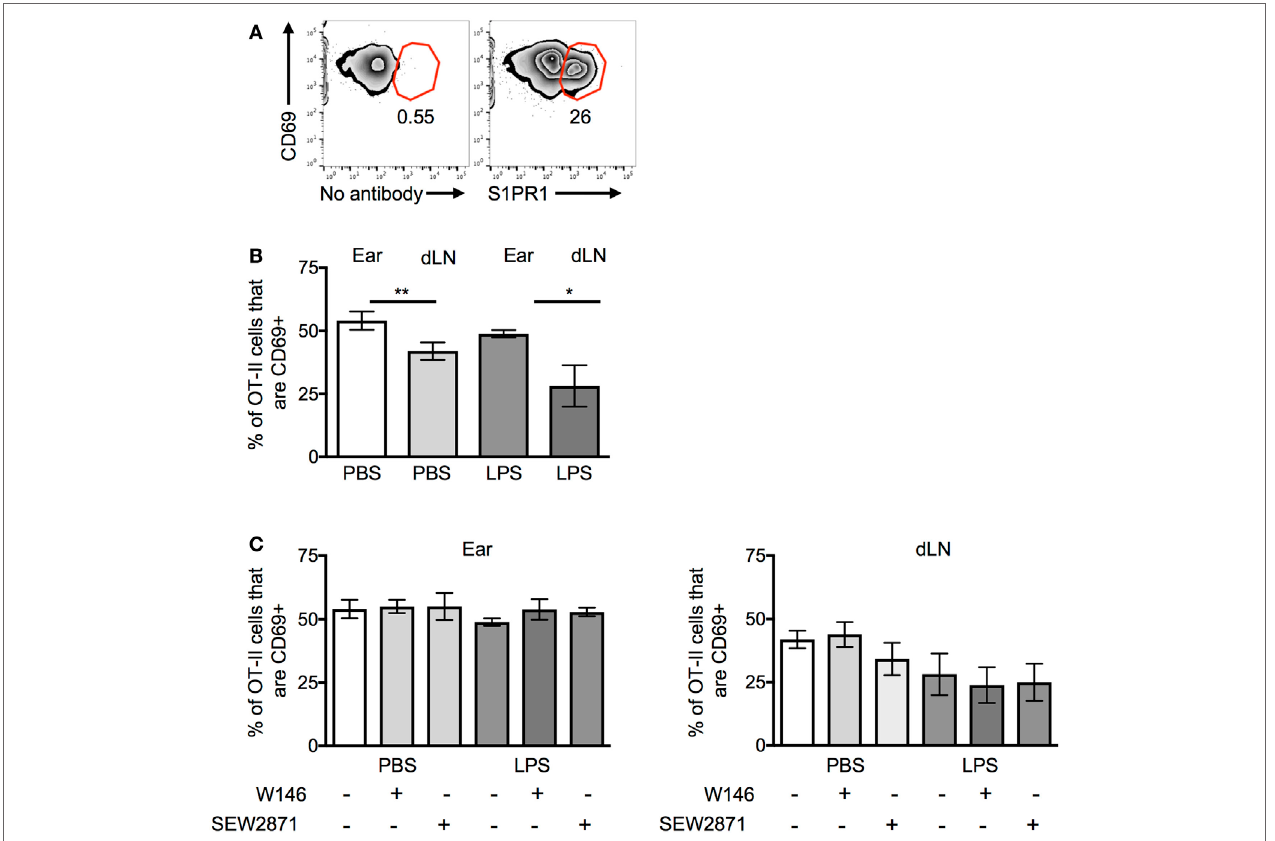
FigUre 6 | CD69 and S1PR1 expression on CD4 T cells before and following cell transfer. Activated OT-II T cells were analyzed before cell transfer (a) for expression of CD69 and S1PR1 or for CD69 expression ex vivo 24 h after transfer into resting (PBS) or inflamed [lipopolysaccharide (LPS)] ear pinnae (B,c) . Before transfer, the OT-II T cells were treated with an S1PR1 antagonist or agonist as in Figure 5B . In panel (a) , cells are gated on live CD4 + CD45 + cells; representative of three independent samples. In panels (B,c) , data are combined from two to three independent experiments with ≥ 3 animals per group. In this figure, p < 0.05 is indicated by * and p < 0.001 by